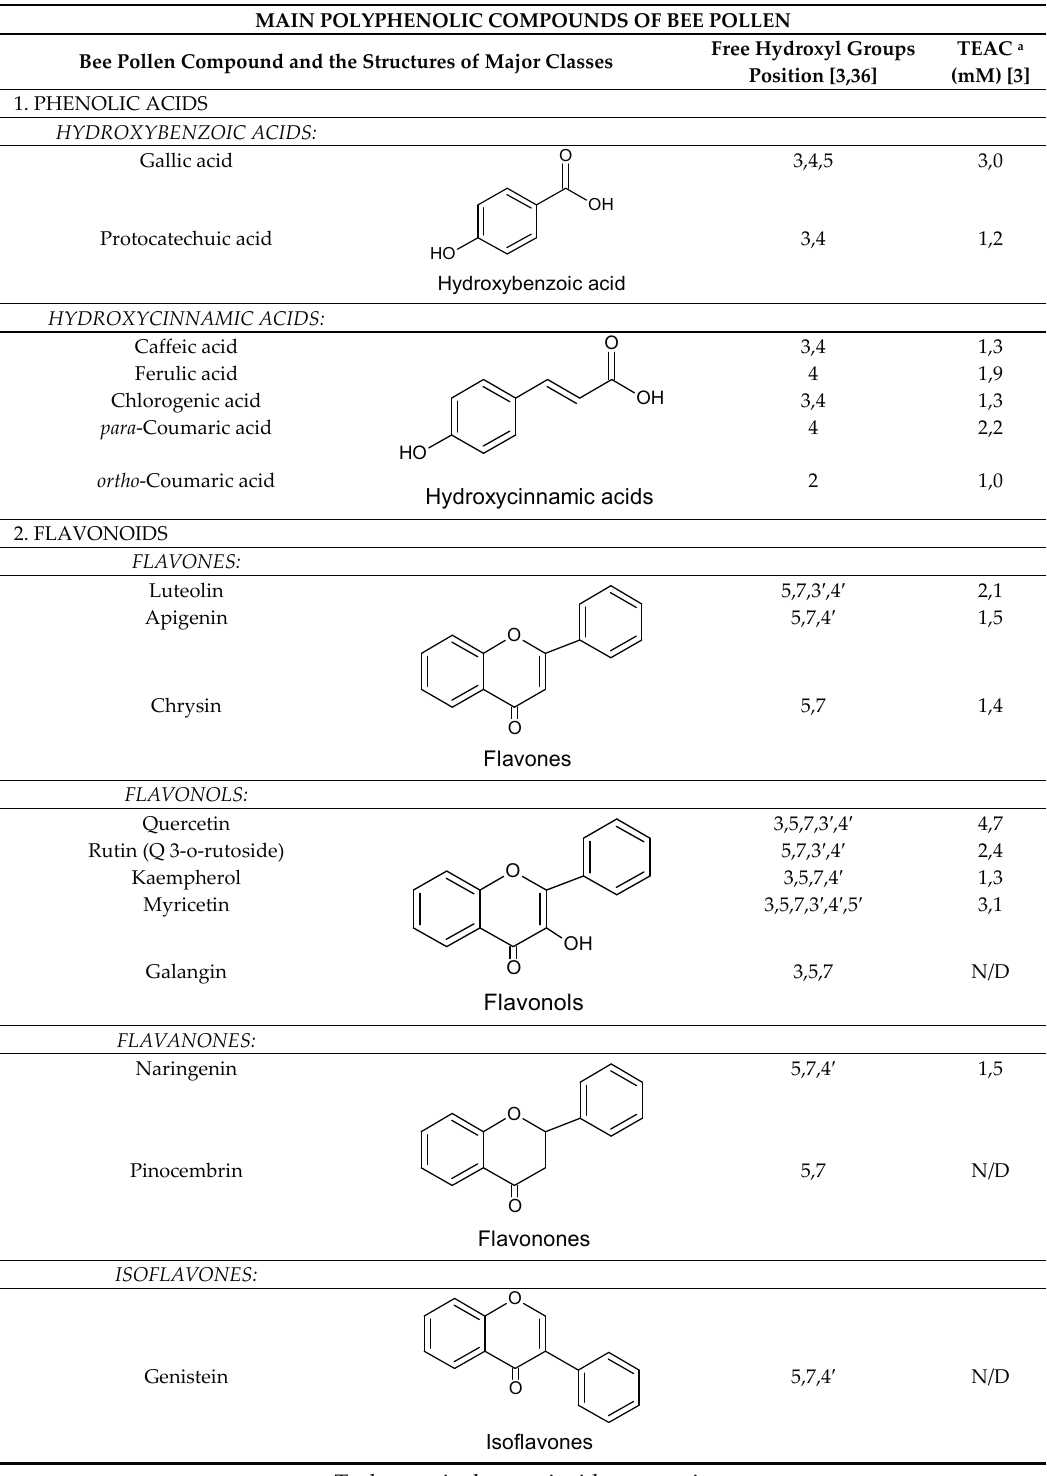
Table 1. Main polyphenolic compounds of bee